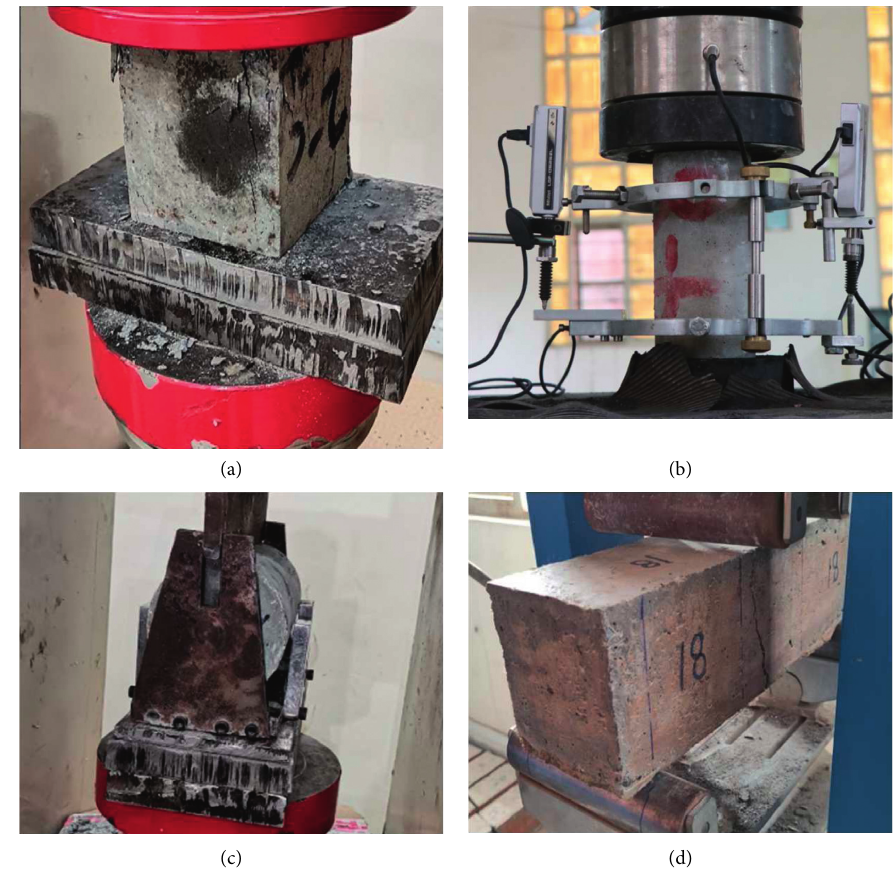
Figure 3: Overview of mechanical testing. (a) Compression test on 100 mm cubes. (b) Overview of axial testing for ECM de- termination. (c) Splitting-tensile test on “100 mm × 200 mm” cylindrical samples. (d) Overview of flexural testing on “100 mm × 100 mm × 350 mm” prismatic samples.